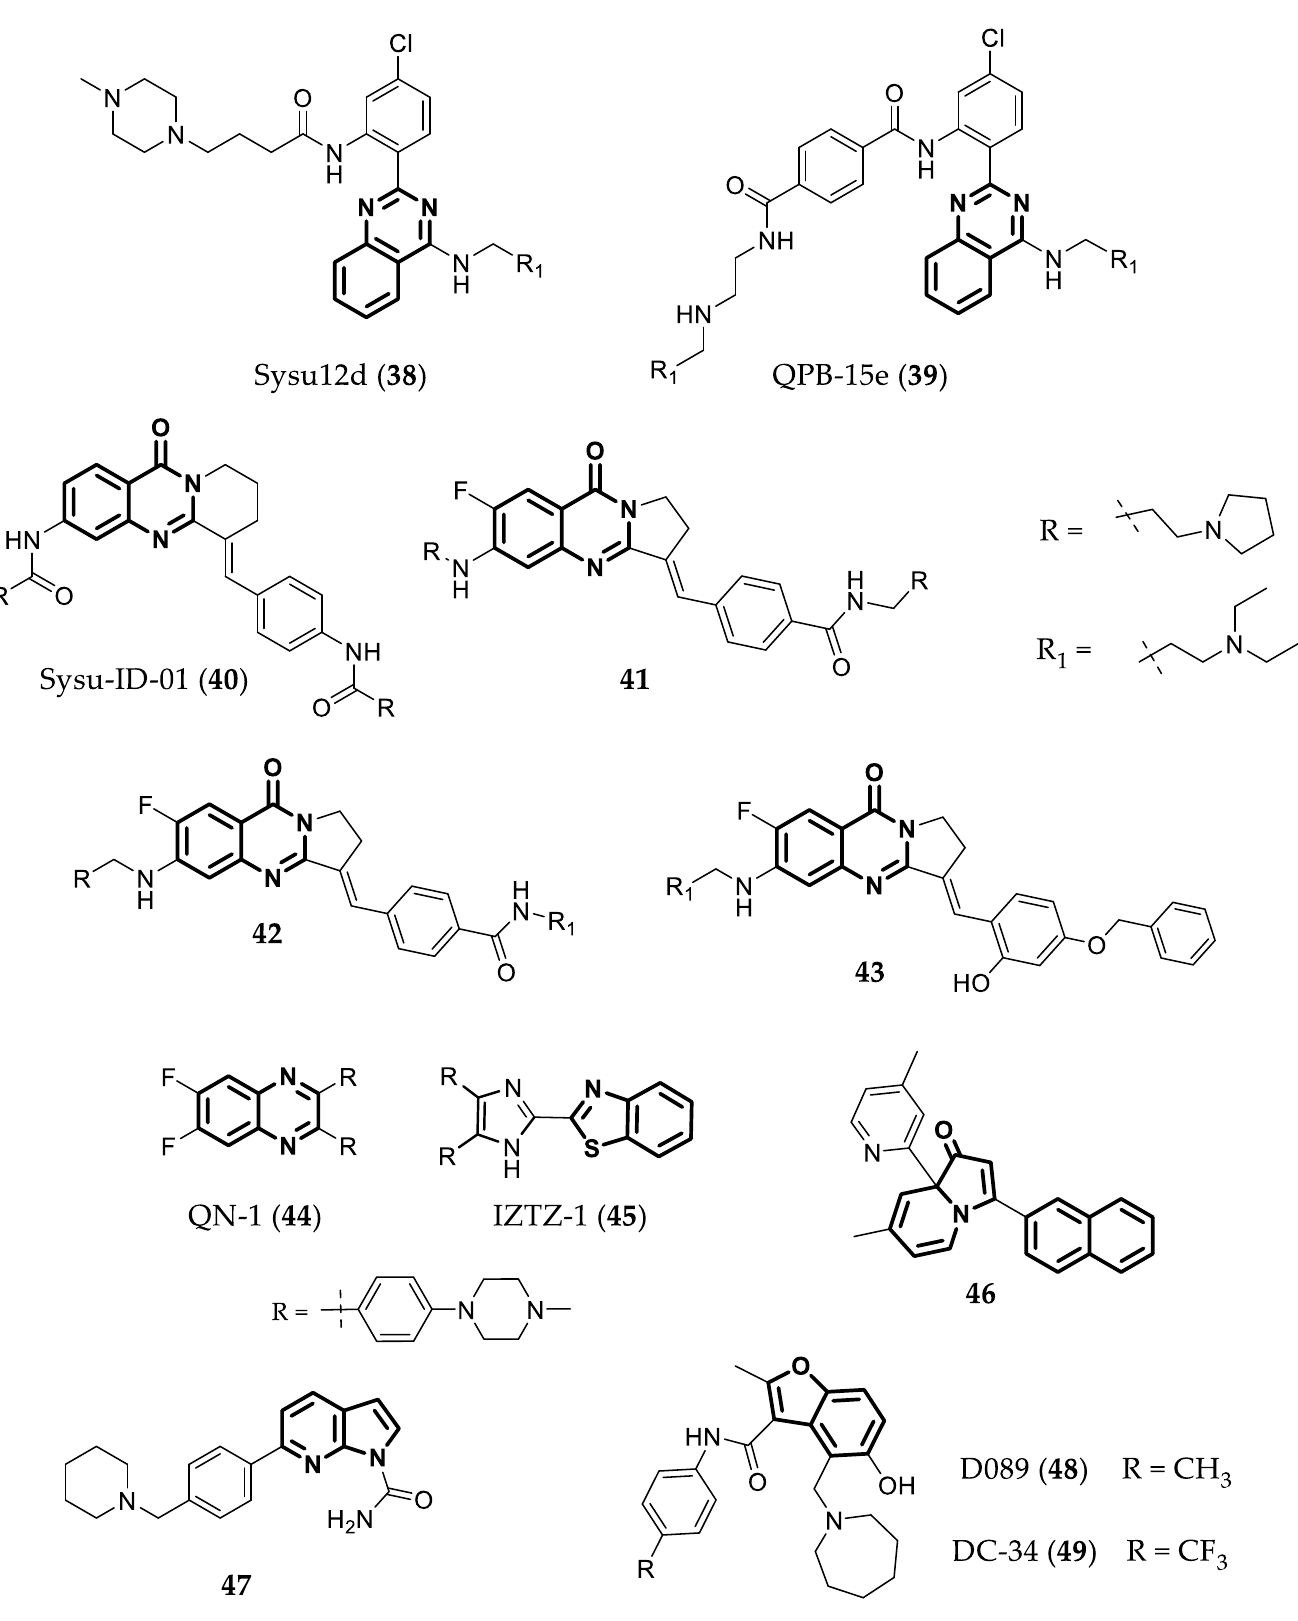
Figure 11. Structure of c-MYC G4 ligands with two fused aromatic rings.